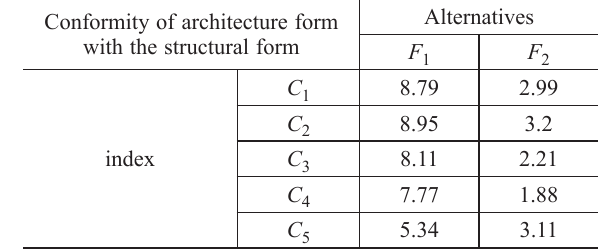
Table 13. Averages of experts’ scores for roof alternatives within the major indexes Types of roofs